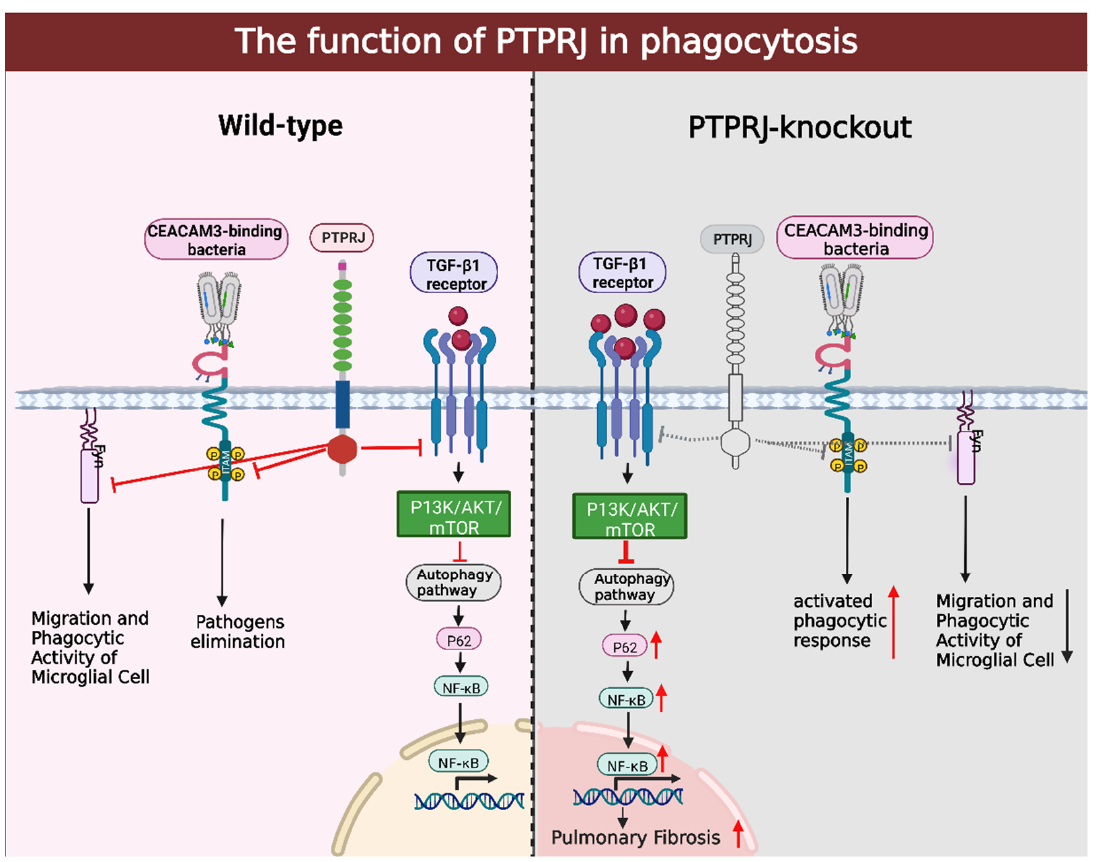
Figure 4. The function of PTPRJ in phagocytosis. The TGF- β 1-induced PI3K/Akt/mTOR signaling pathway could be enhanced by PTPRJ deficiency, blocking the autophagic pathway and resulting in p62 accumulation. In contrast, overexpression of PTPRJ can decrease the accumulation of p62 and have an anti-fibrotic effect by suppressing p62-dependent NF- κ b-mediated production of pro- fibrotic gene expression. PTPRJ alters and decreases CEACAM3 phosphorylation, thereby negatively regulating CEACAM3-medi- ated phagocytosis and limiting the potential inflammatory response. PTPRJ positively regulates microglia migration and phagocy- tosis through dephosphorylation of microglia at the Tyr42 site of the Fyn tyrosine kinase. This figure was created using BioRender